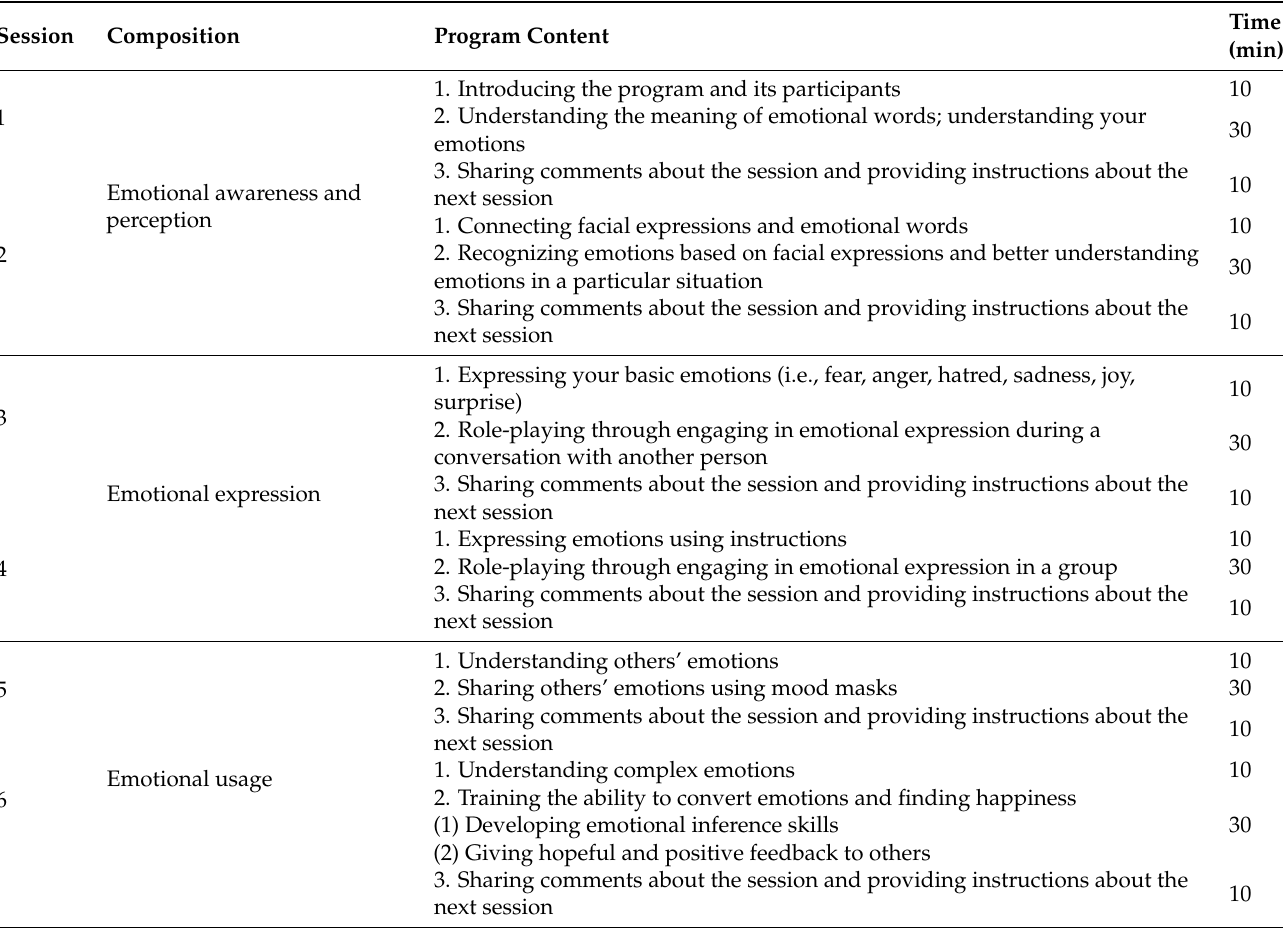
Table 1. Description of the short emotional management program (EMP-S) developed in this